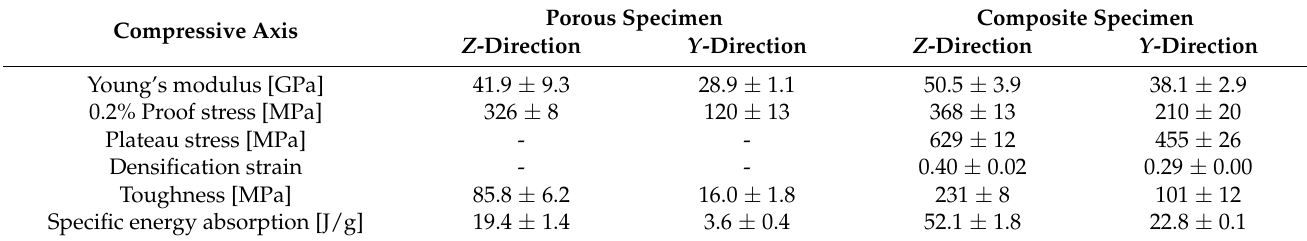
Table 1. Mechanical properties of porous and composite specimens fabricated by EB-PBF and subsequent heat treatment. Porous Specimen Composite Specimen Compressive Axis Z -Direction Y -Direction Z -Direction Y -Direction Young’s modulus [GPa] 41.9 ± 9.3 28.9 ±